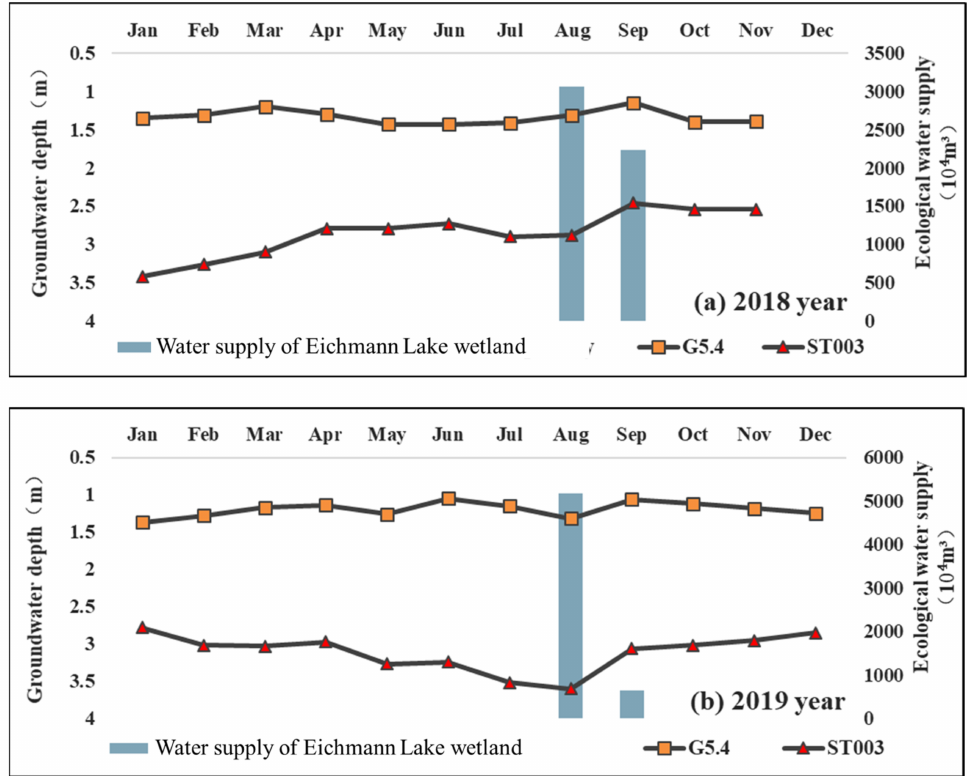
Figure 5. Observed changes in groundwater depth in monitoring wells under ecological water supply conditions in 2018 ( a ) and 2019 ( b